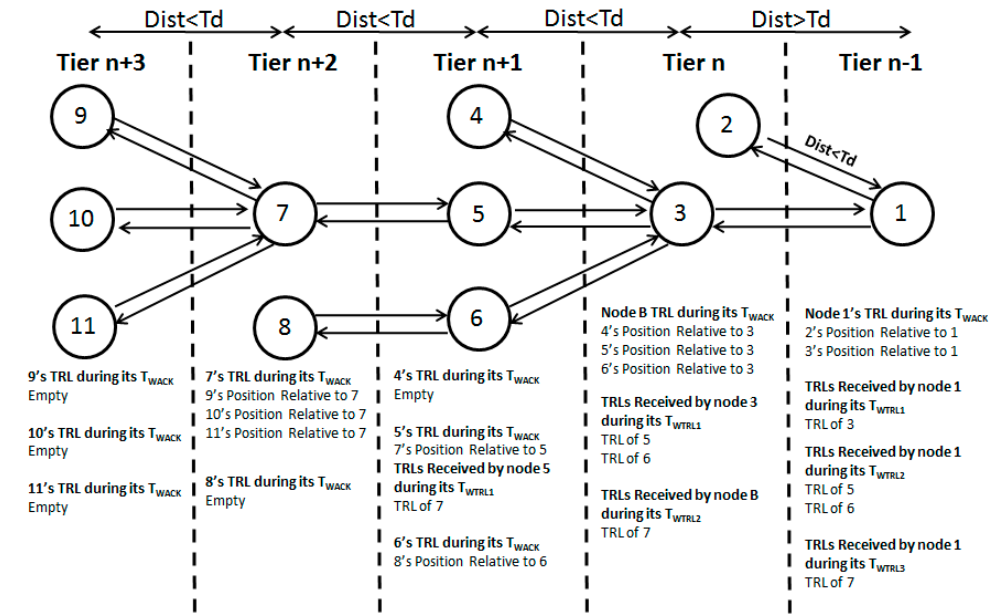
Figure 4. Beacon propagation.